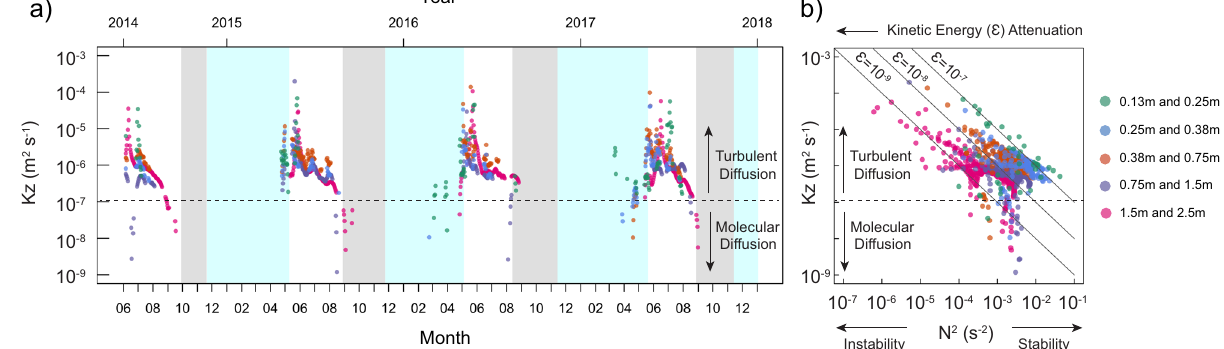
Fig. 4 Vertical diffusion coef fi cient over time and as a function of thermal stability. a Timeseries of the apparent diffusion coef fi cient ( K app ; m 2 s − 1 ) between two adjacent porewater depths between June 2014 and January 2018, derived from the heat budget method and b scatterplot of the K app in relation to the buoyancy frequency (N 2 ; s − 2 ) between the same pairs of porewater depths. Symbols are coloured based on the pairs of porewater depths, 0.13 to 0.25 m (green), 0.25 to 0.38 m (blue), 0.38 to 0.75 m (orange), 0.75 to 1.5 m (purple), 1.5 to 2.5 m (magenta). The horizontal dotted lines in both a and b mark the threshold between the turbulent and molecular rate of diffusion. Oblique full lines in b indicate the theoretical relationship between K z and N 2 described by Eq. (1) 24 , under different levels of kinetic energy input ( ε = 10 − 7 to 10 − 9 m 2 s − 3 ) and a constant γ mix of 0.10. In a , the x-axes indicate the dates, with years on top and month numbers on the bottom axis. In a , the background areas coloured in grey and cyan mark the periods of weak thermal stability and ice/snow cover on the peatland surface,